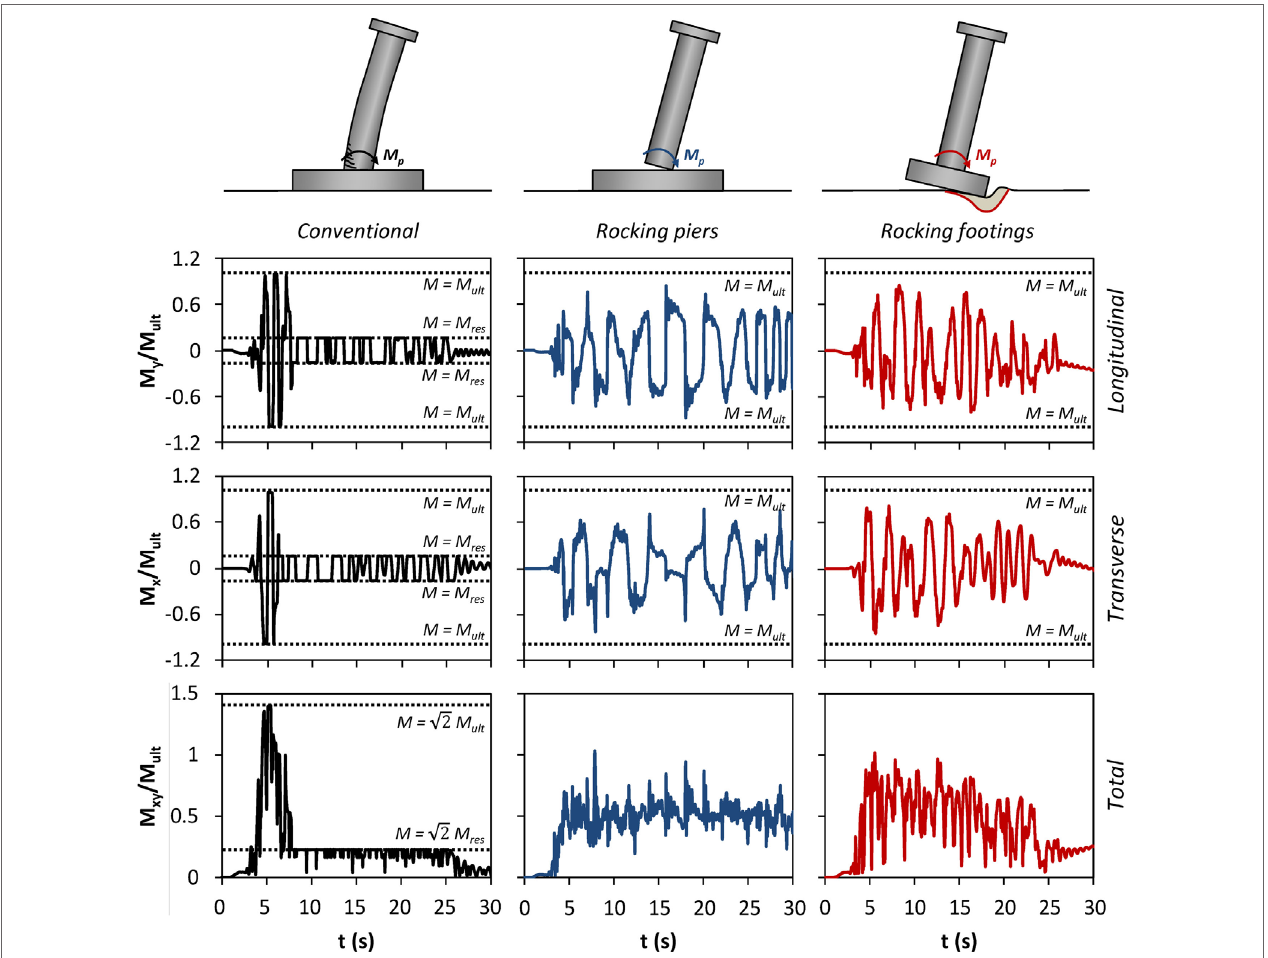
FigUre 11 | Comparison of the three design alternatives in terms of normalized moment at each direction and total moment to moment capacity time histories M/M ult , indicatively for pier P4 for the Takatori